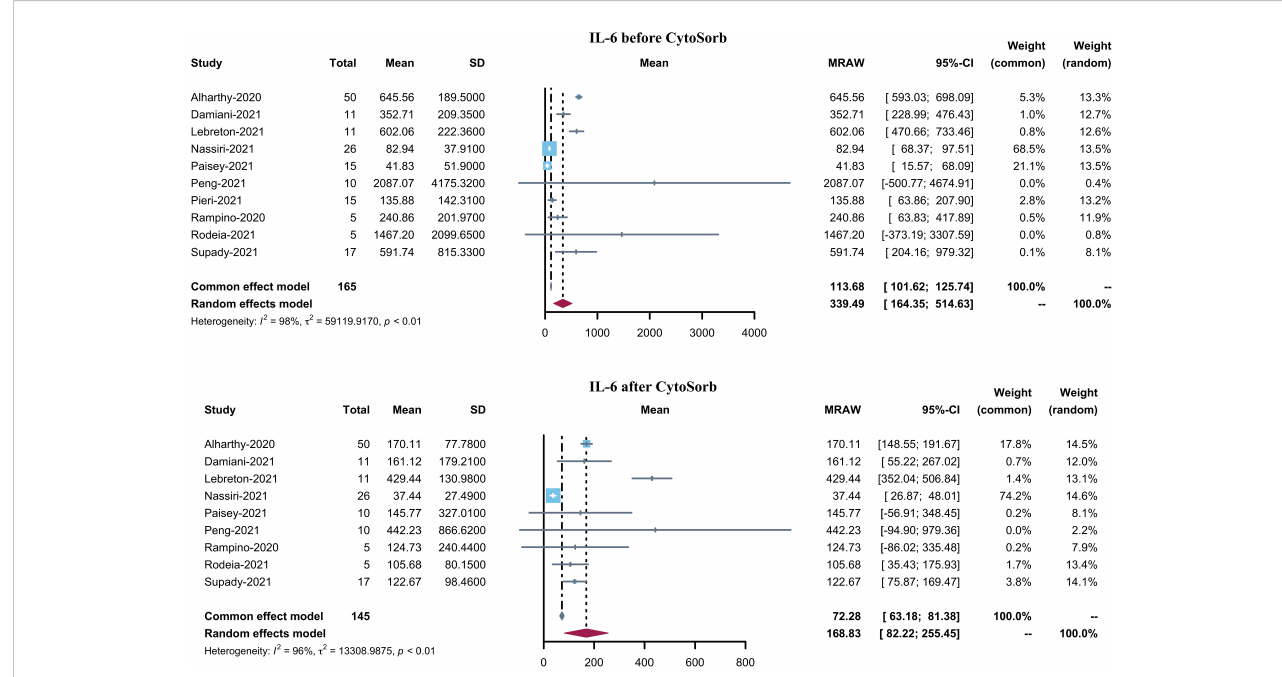
FIGURE 4 Forest plot of serum IL-6 before and after CytoSorb treatment for COVID-19 patients. CI: con fi dence interval; SD: standard deviation; IL-6: